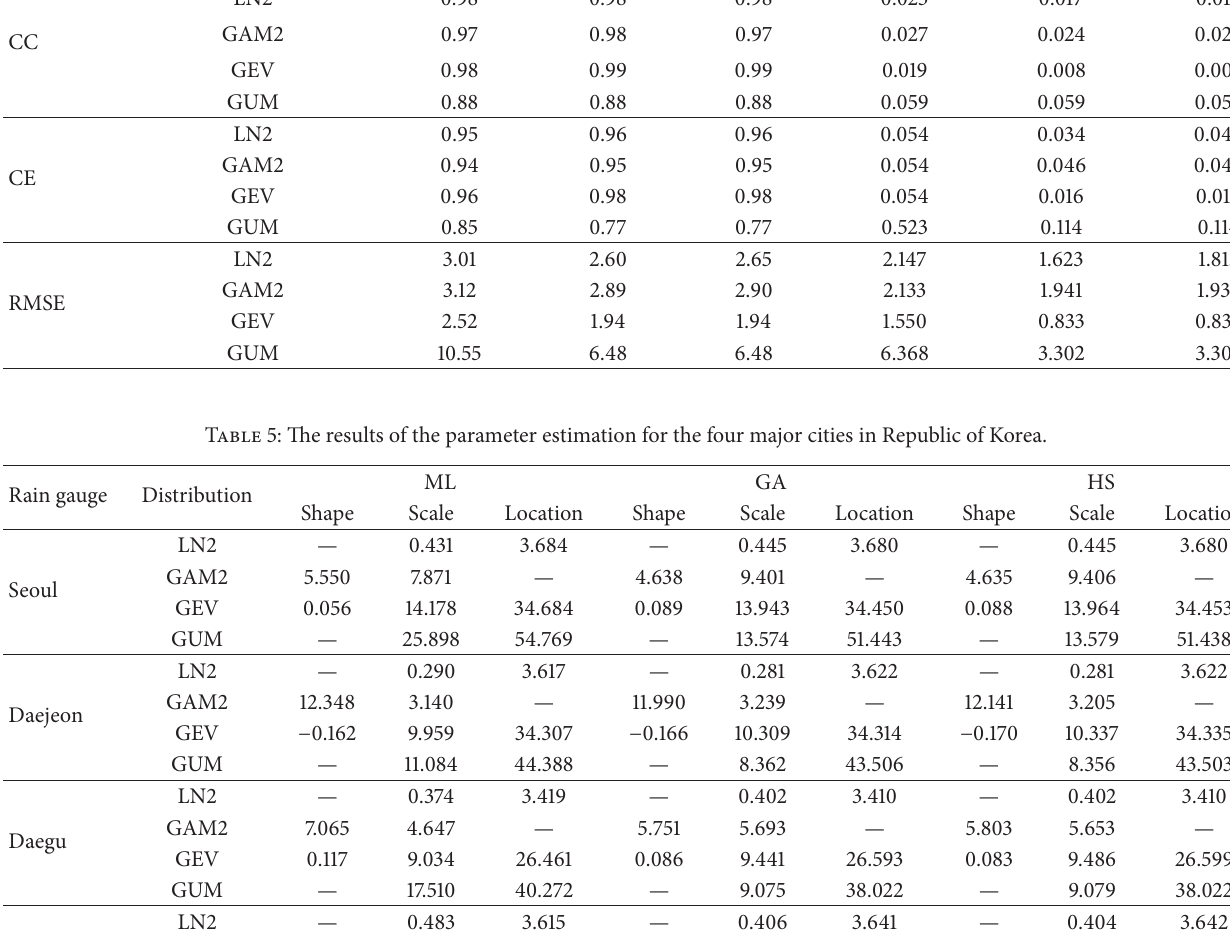
Table 4: Comparison of test criteria for the annual maximum rainfall data for the 74 rain gauges stations in Republic of Korea. Criteria